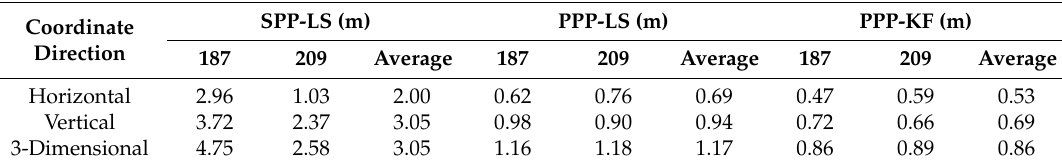
Table 2. Horizontal, vertical, and three-dimensional kinematic positioning accuracies in meters: SPP, LS, and KF. Two test drives were conducted on DOY 187 and DOY 209 in 2015, and ‘average’ indicates two-day averages.